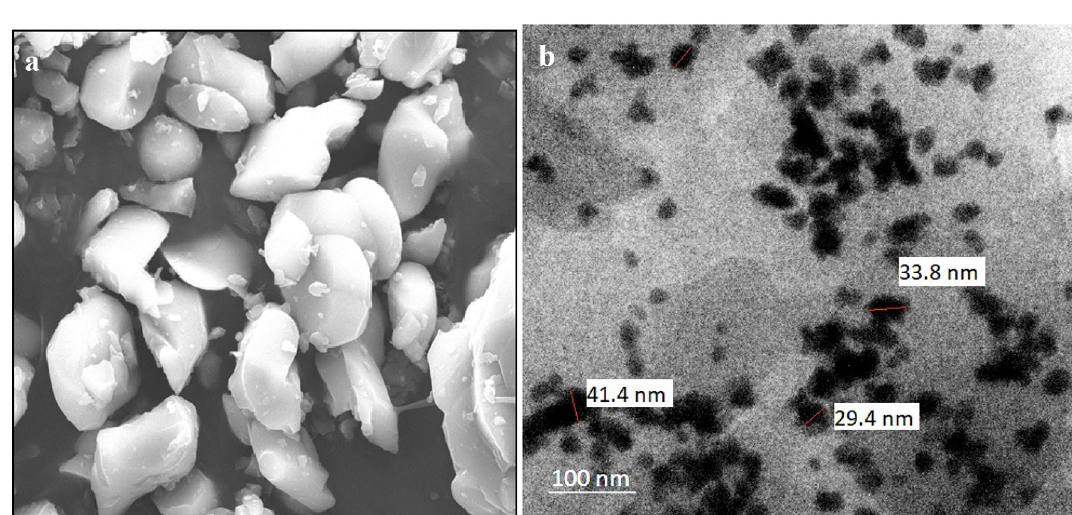
Figure 3. ( a ) SEM images of synthesized ZnO NPs; ( b ) TEM images of synthesized Zno